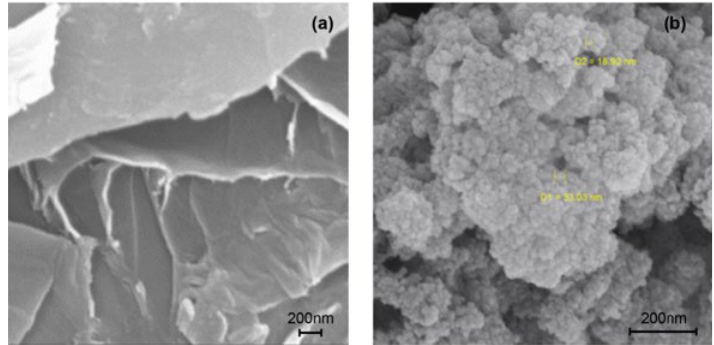
Fig. 1. SEM images of (a) GO and (b) zeolite N.P./PEG/GO nano-composite